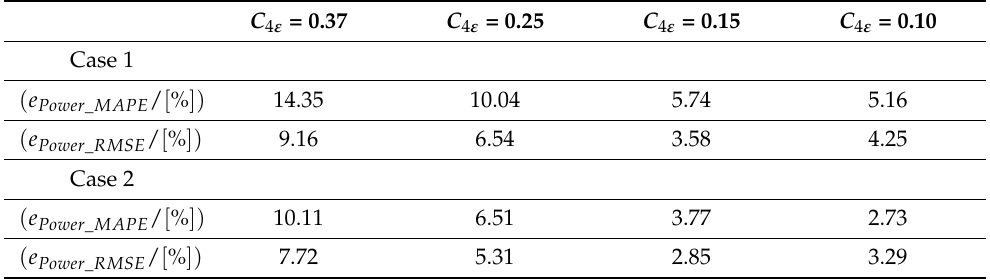
Table 6. Error analysis of power simulation of six cases with different parameter C 4 ε values. C 4 ε =